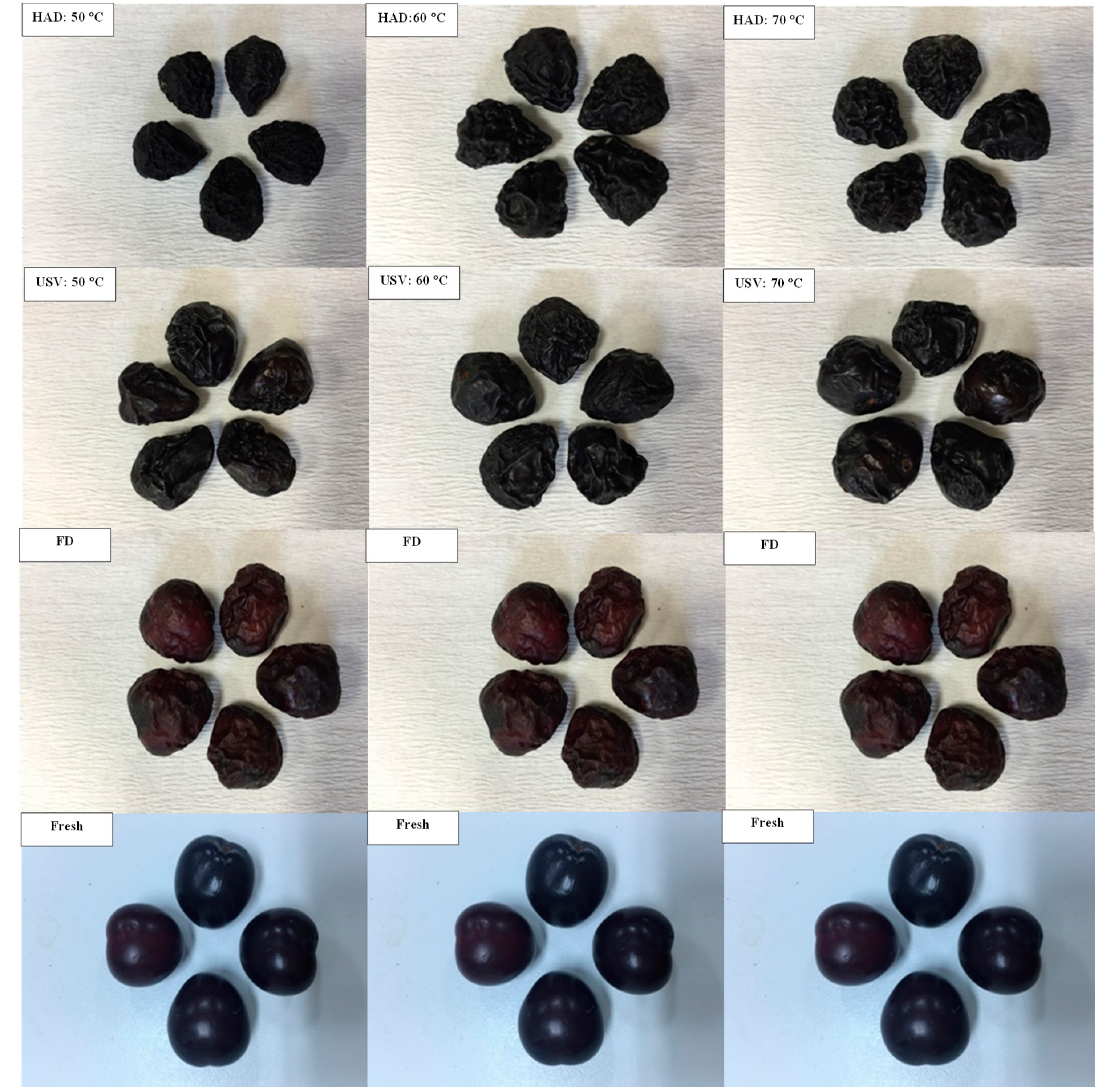
Figure 3. The pictures of the dried and fresh samples of cherry laurel (HAD, hot air drying; USV, ultrasound-assisted vacuum drying; FD,